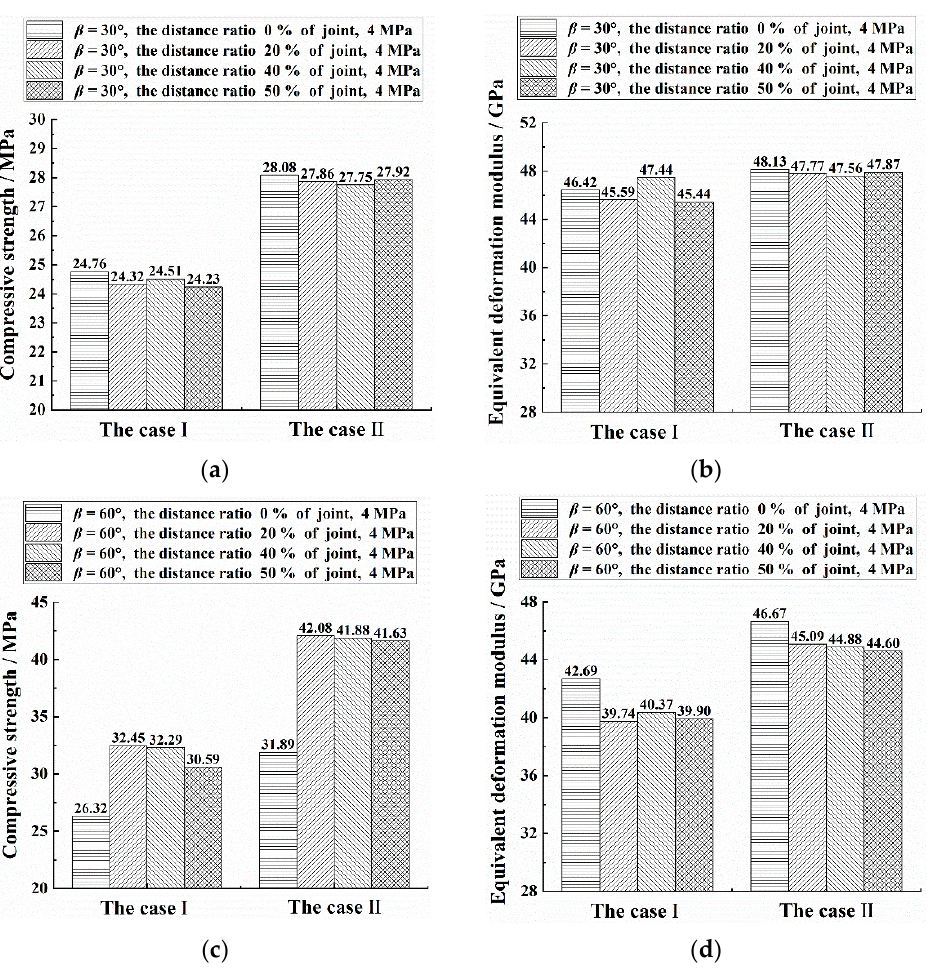
Figure 6. For the cases of two kinds of model boundaries and the CJBs with different joint distance ratios: ( a , c ) the compressive strength for β = 30° and 60°; ( b , d ) the equivalent deformation modulus for β = 30° and 60° (Case Ⅰ corresponding to the case between plane stress and plane strain and Case Ⅱ corresponding to the plane strain).